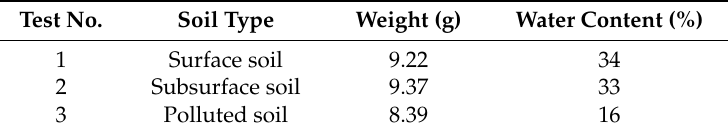
Table 2. Soil samples and test conditions used for microbial decomposition tests. Test